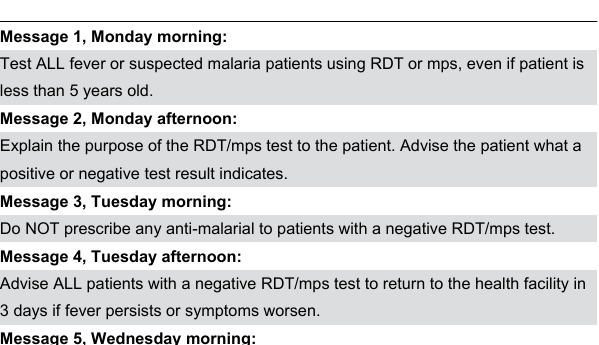
Table 1. Text message content and transmission schedule.